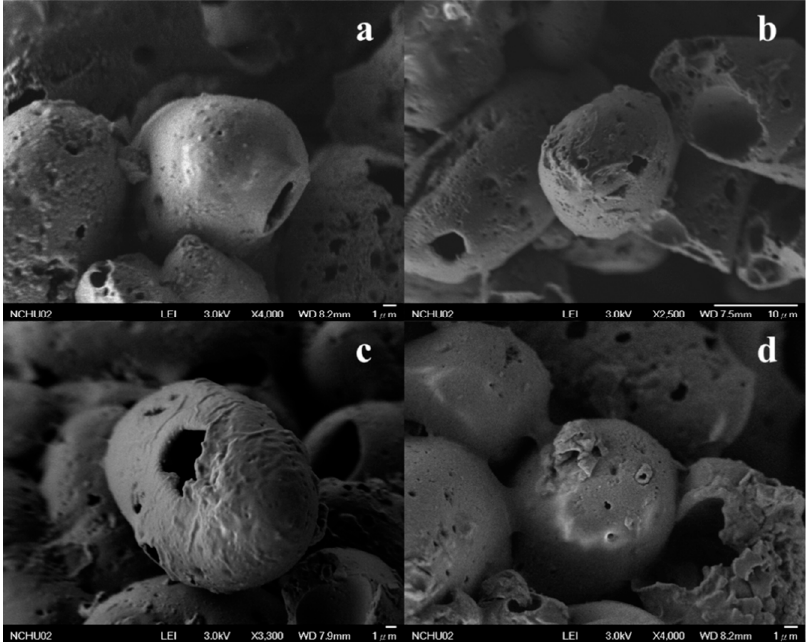
Figure 1. The scanning electron microscopy (SEM) images of the OMC/SiO 2 nanoparticles ( a , b ) and hollow spheres of OMC/SiO 2 nanoparticles ( c , d ).